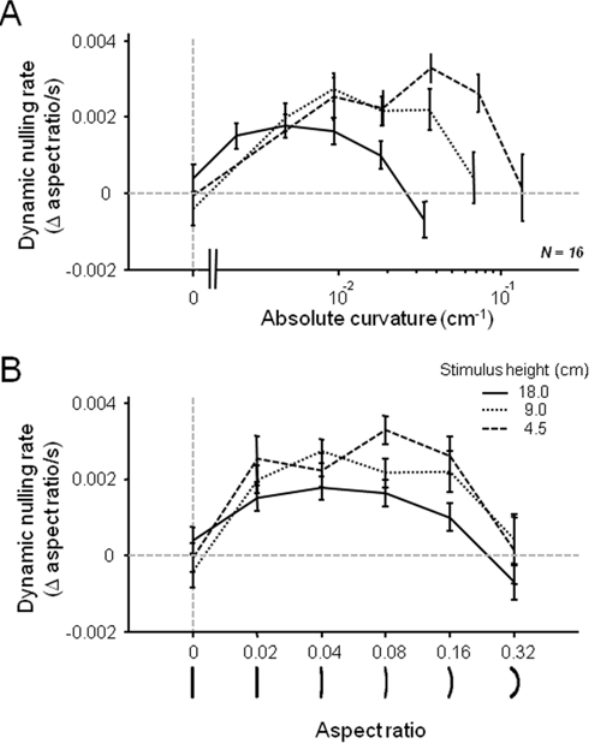
Figure 5. Size constancy of perceptual drift for curvature. Adaptors of three sizes ranging over a factor of 4 were used to determine effect strength of adaptation through dynamic nulling (N=16 subjects, partially overlapping those in Figure 4). The display was 114 cm, i.e. 1 cm foveally corresponds to K deg visual angle. Since that approximation is invalid for larger values, units are given in cm. A. Data plotted against absolute curvature, with smallest stimuli having the highest curvature (dashed line) and largest stimuli having the lowest curvature (solid line). B. The exact same data plotted against aspect ratio for the three different sizes. Note that aspect ratio, rather than absolute curvature, determined the rate at which the stimulus perceptually straightened. Data were collected for convexities in both directions and then combined. Error bars represent s.e.m over subjects.